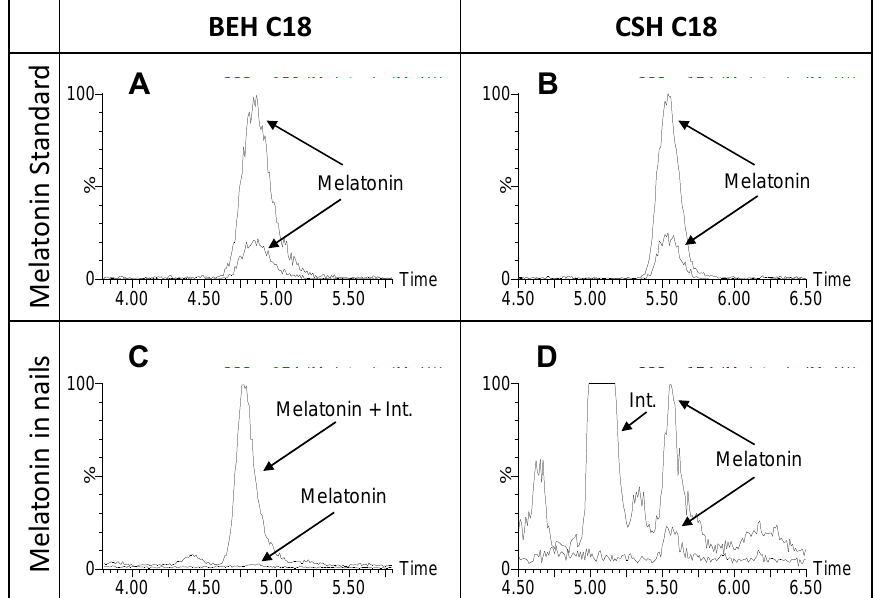
Figure 1. Relevance of chromatography in the LC-MS/MS detection of nail melatonin content. LC- MS/MS chromatograms for the two selected transitions of melatonin (233 > 174 and 233 > 159) in standard (250 pg mL − 1 ) ( A ) and ( B ) and in a nail sample (31 fg/mg) ( C , D ). Chromatograms obtained